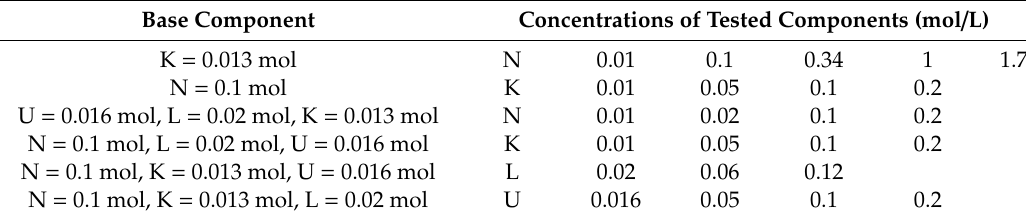
Table 2. Mixtures under test (synthesized by dissolving in 1 L of distilled water).